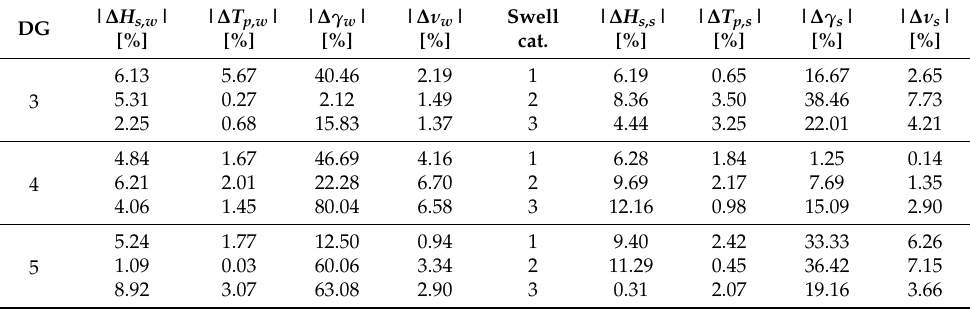
Table 6. Sea state assessment (Thomson)—short duration and high frequency.